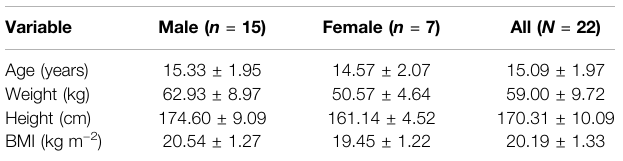
TABLE 1 | The participants ’ demographic